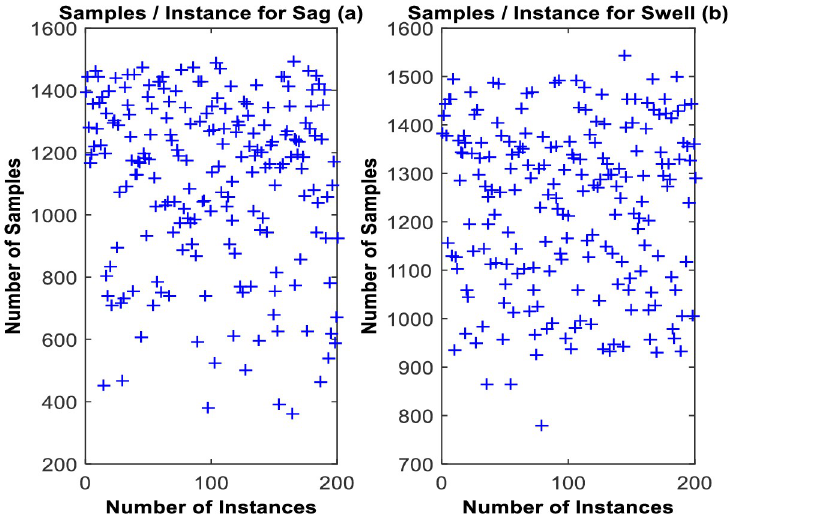
Fig 7. Number of samples per instance for sag (left) and swell (right).